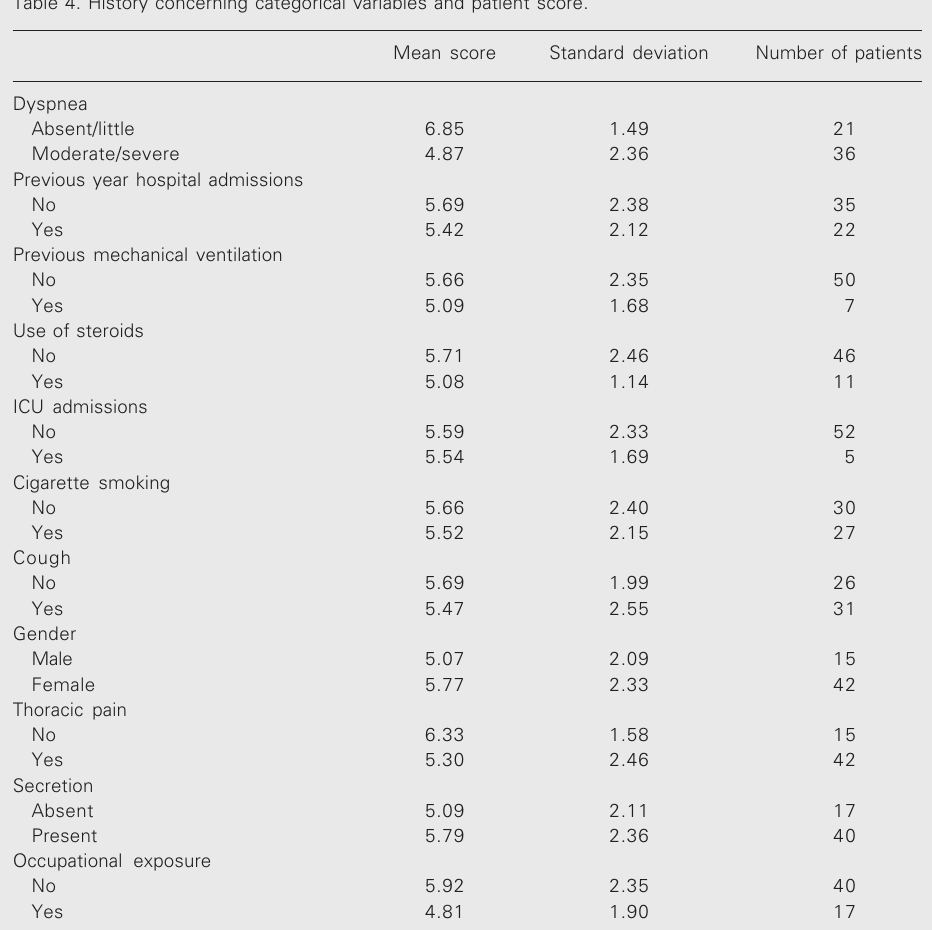
Table 4. History concerning categorical variables and patient